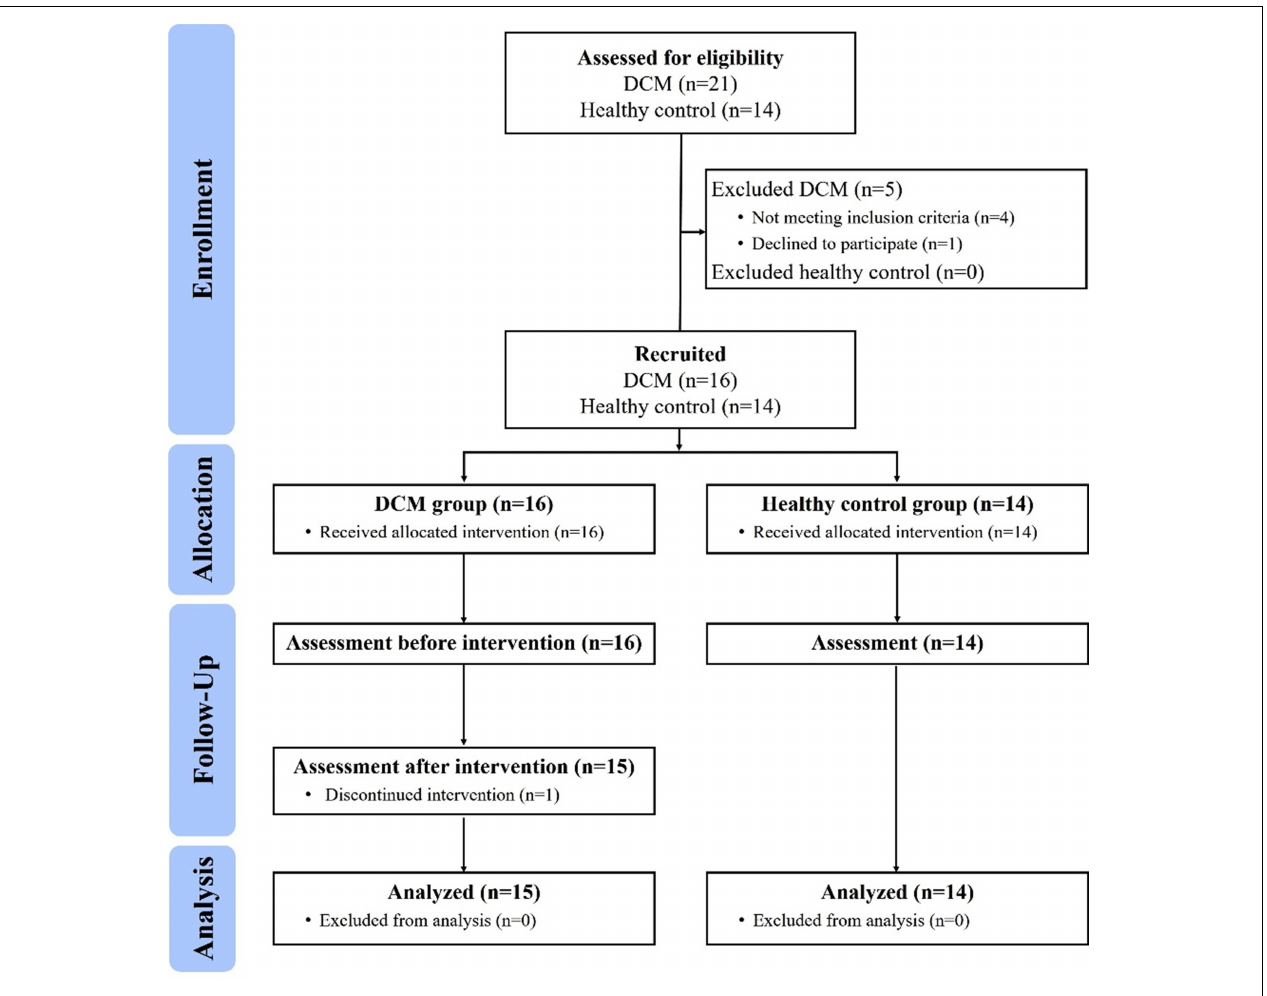
FIGURE 2 | Flow chart of the